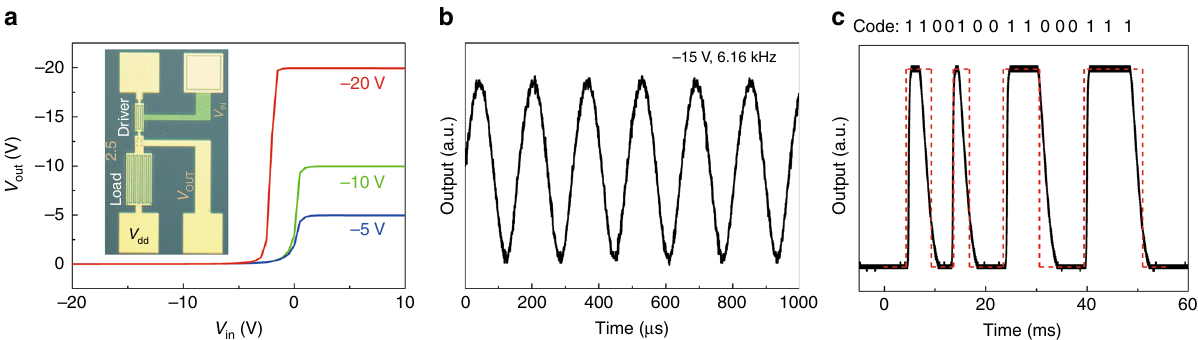
Fig. 4 Integrated circuits based on PffBT4T-2DT PoM-FETs. a Static input – output characteristics of a unipolar inverter based on PffBT4T-2DT monolayer with V GS = 0 V. The supplied voltage, V dd , is − 5 V, − 10 V, and − 20 V, respectively. The inverter layout is shown as an inset. b A PoM-FET 7-stage ring oscillator operating at a frequency of 6.16 kHz with a supply voltage of − 15 V. c A PoM-FET 15-bit code generator with a bit rate of about 330 bit s − 1 at V = − dd